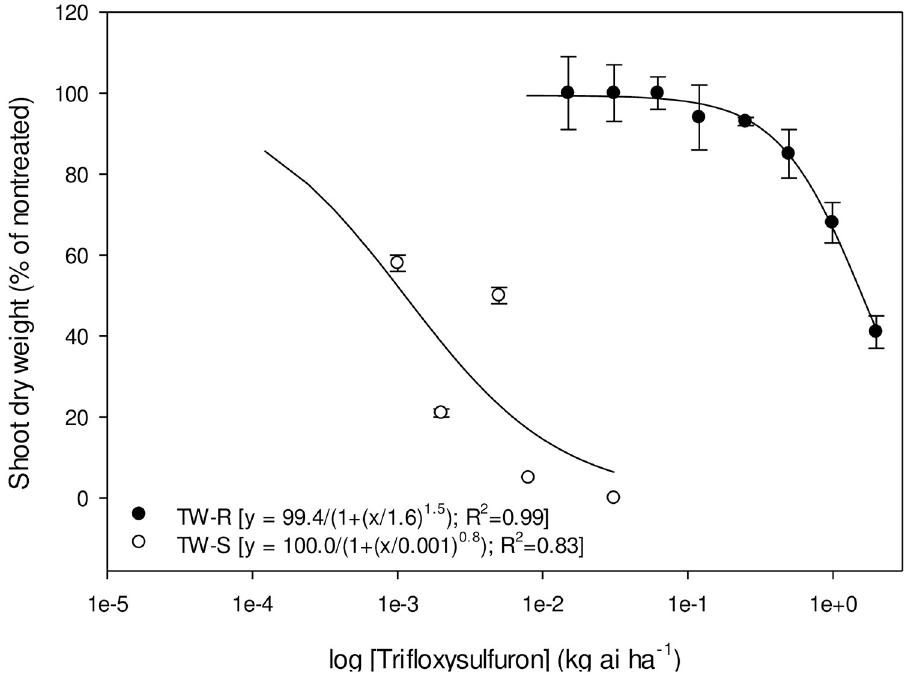
Fig 6. Trifloxysulfuron dose response on shoot dry weight reduction of ALS-inhibiting herbicide-resistant (TW-R) and -susceptible (TW-S) Amaranthus tuberculatus populations from Mississippi 3 wk after treatment. Vertical bars represent standard error of